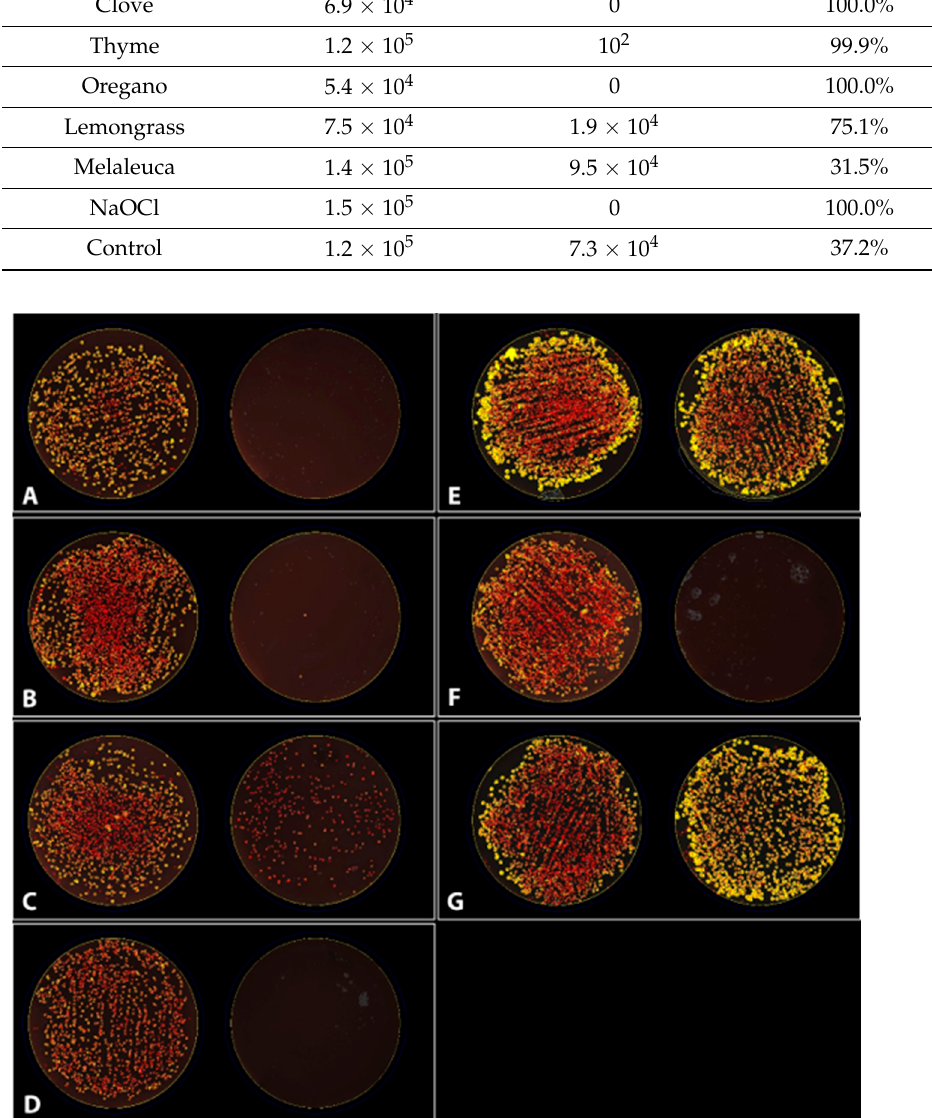
Figure 4. bacterial growth after canal irrigation with the tested solutions. ( A ) Oregano; ( B ) Thyme; ( C ) Lemongrass; ( D ) Clove; ( E ) Melaleuca; ( F ) NaOCl; ( G ) Saline—control. Each panel presents the plates before and after treatment.